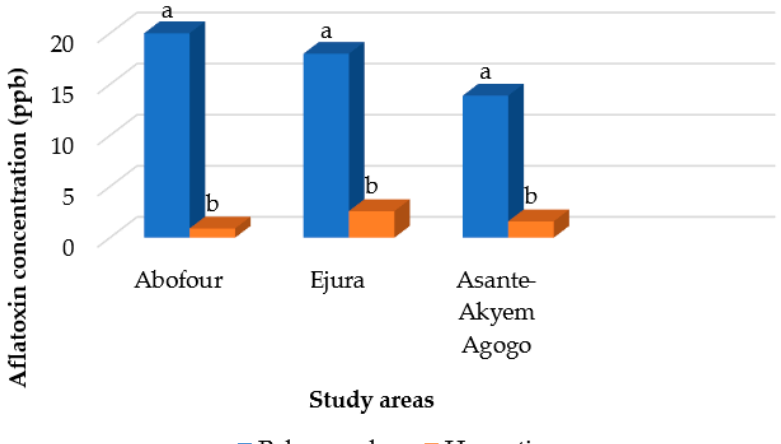
Figure 2. Aflatoxin concentration of maize stored in hermetic and polypropylene storage bags. Means within the graph followed by a different letter are significantly different at p < 0.05 (ANOVA: t -test).